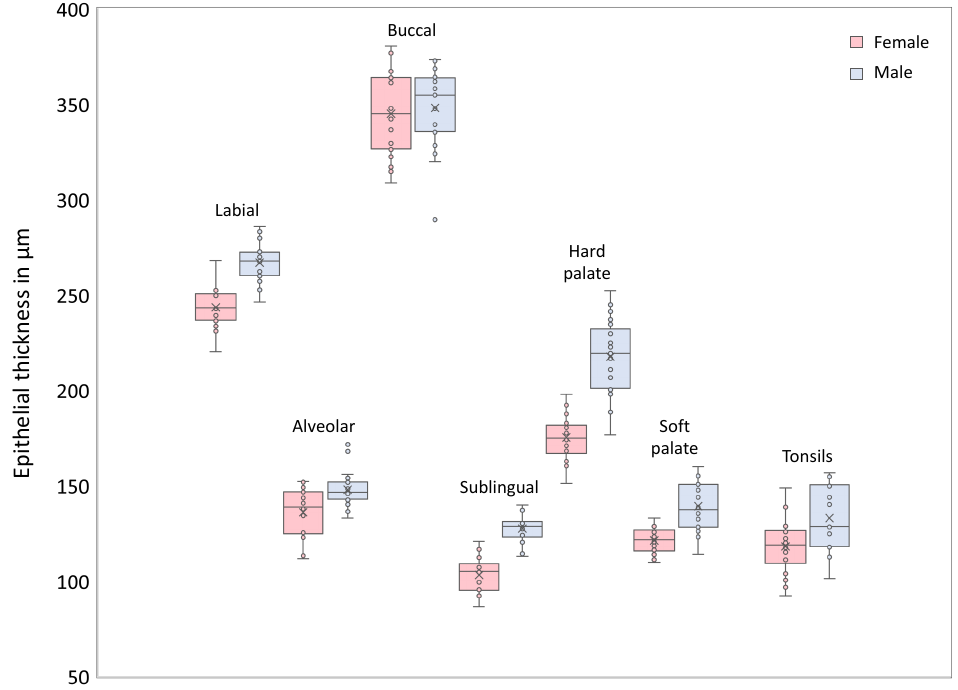
Figure 11. Box plot of the gender-specific epithelial thickness of recommended measurement points. The limited selection of distinctive measurement points is conceivable to serve as prospective parameter for assessing oral health. Labial: MP4, Alveolar: MP5, Buccal: MP7, Sublingual: MP9, Hard palate: MP12, Soft palate: MP13, Tonsils: